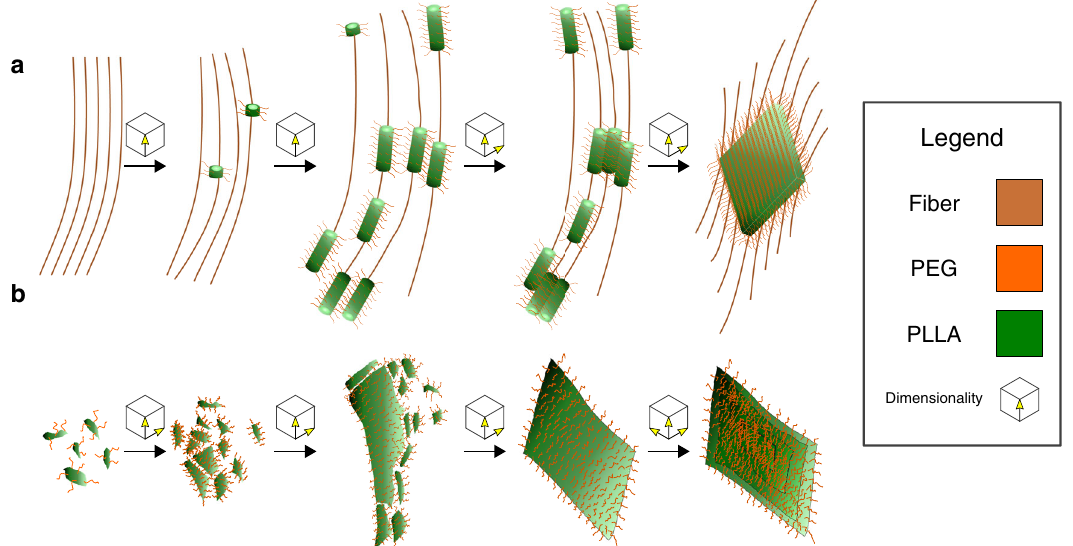
Fig. 7 ROPI-CDSA mechanisms. a Proposed mechanism for PLLA 45 - b -PEG 45 (10% solids w/w 9 ), favoring unimer growth. First, fi bers form as a template for 1D growth, giving spheres and rods. Later, these rods aggregate to form 2D lamellae. b Proposed mechanism for PLLA 90 - b -PEG 45 (10% solids w/w 15 ), favoring aggregation. First, ill-de fi ned 2D rod-like structures form and grow via aggregation. Later, 2D lamellae aggregate, giving 3D lamella